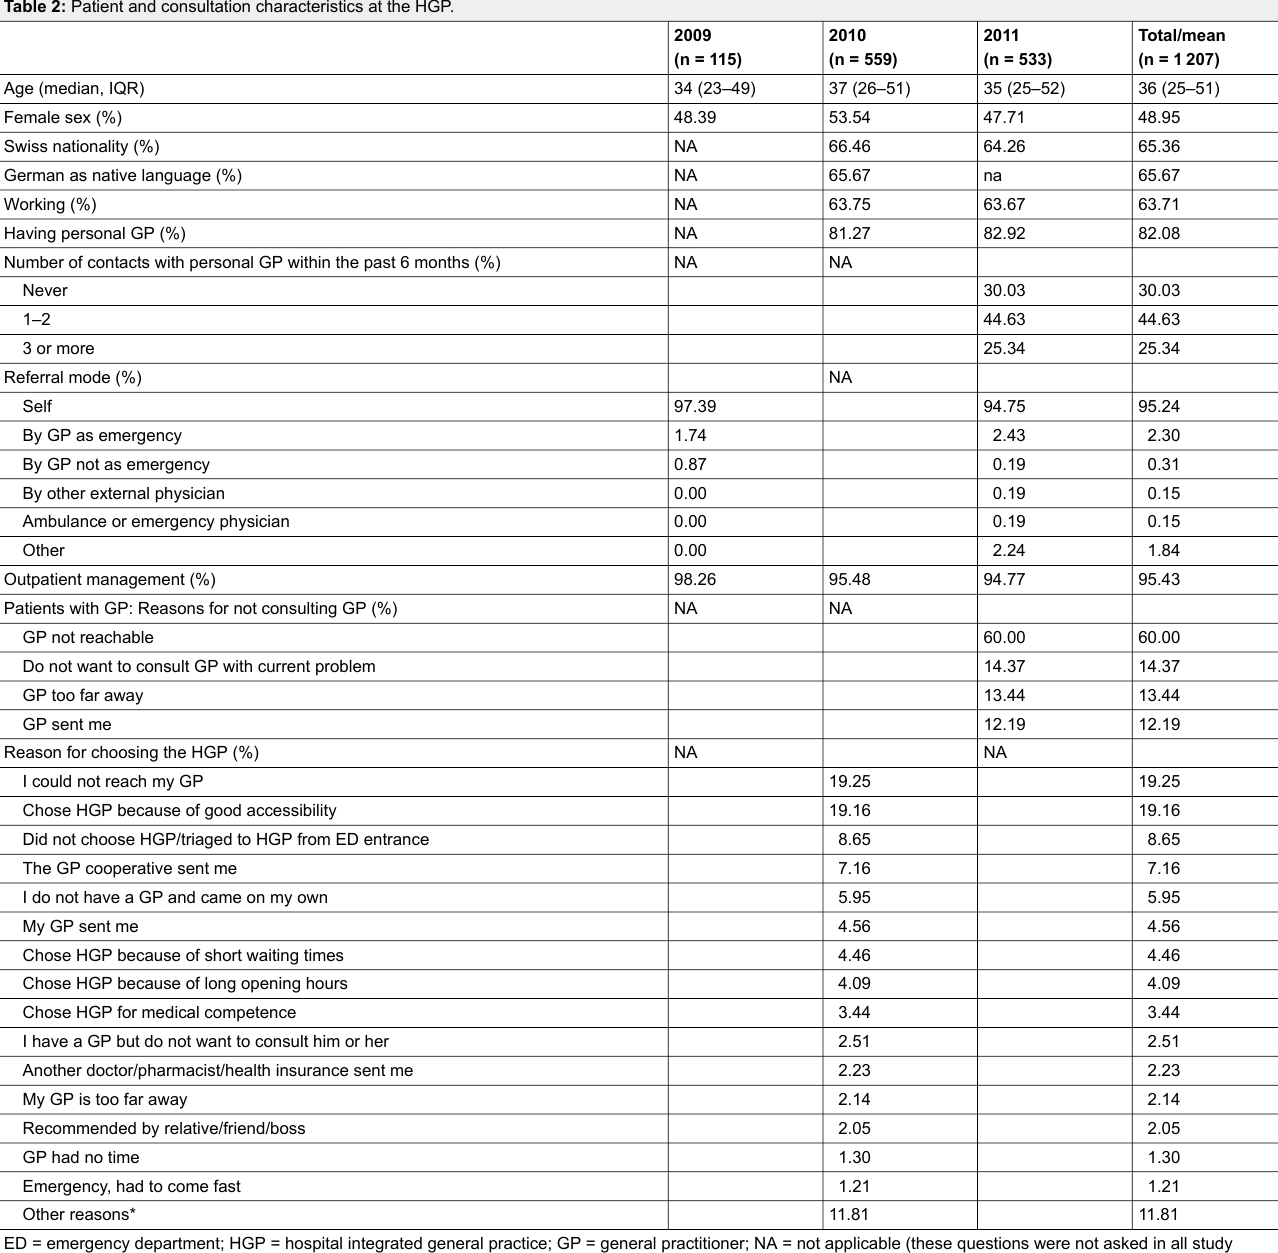
Table 2: Patient and consultation characteristics at the HGP.